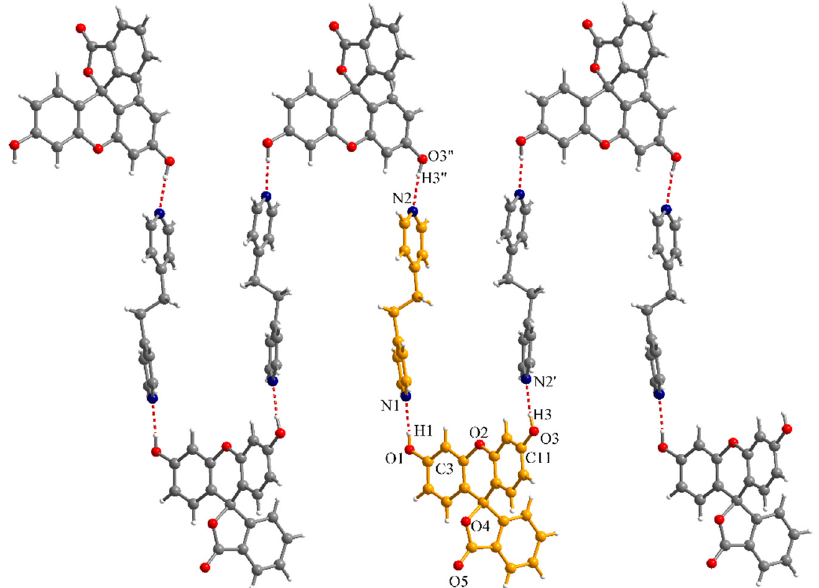
Figure 10. Perspective view of the supramolecular chain formed through hydrogen interactions in crystal 5 . The asymmetric unit is depicted in orange. Symmetry codes: ’ = 1.5 − x, − 0.5+y, 1 − z; “ = 1.5 − x, 0.5+y, 1 − z.